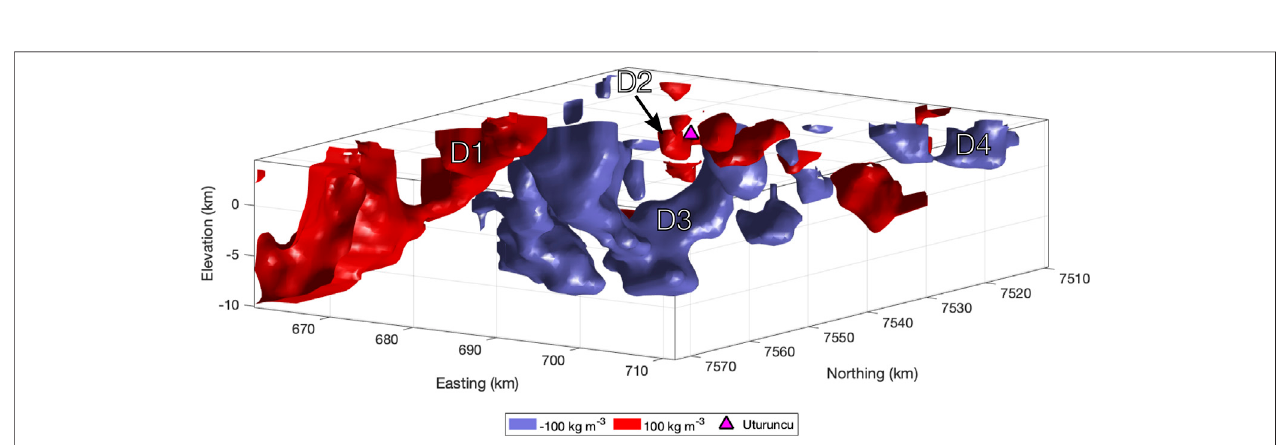
FIGURE 6 | ± 100 kg m − 3 isosurfaces of the middle density model (density contrast bounds (cid:1) ± 150 kg m − 3 ). Model view is upwards from below.